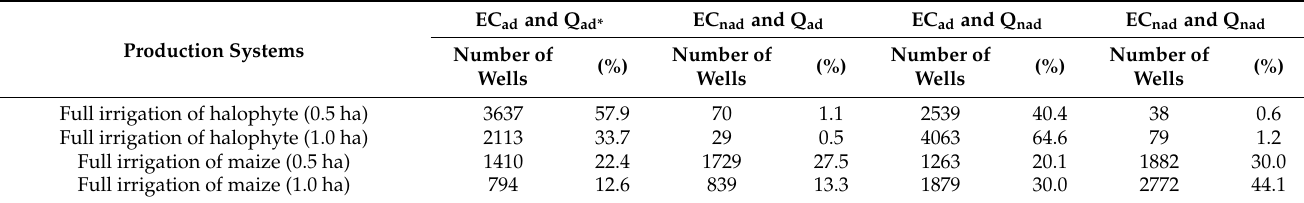
Table 5. Number and percentage of wells for the productive systems tested and considering the different suitability